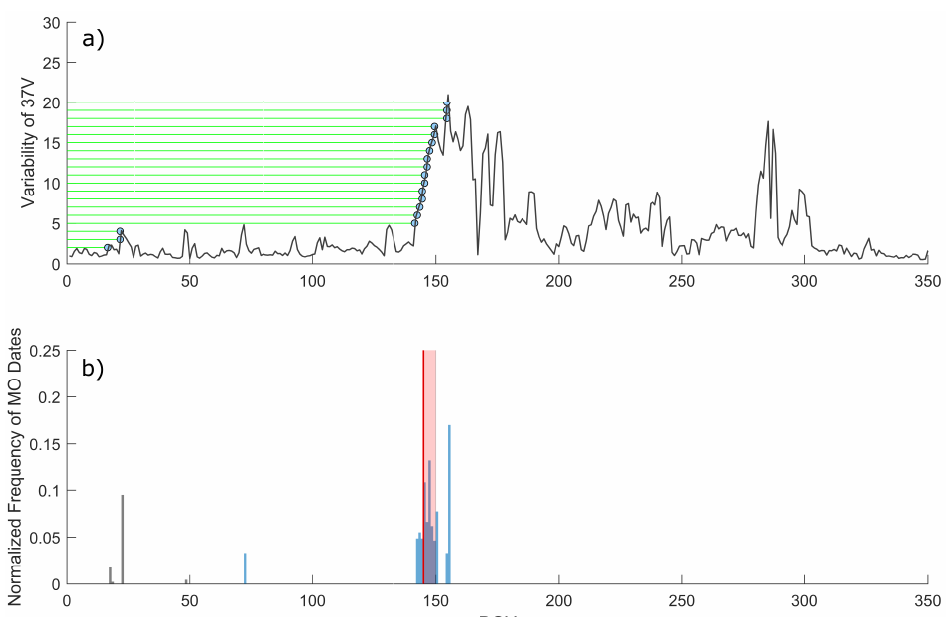
Figure 2. Data from pixel at [69.87 ◦ N, − 88.15 ◦ W], 2017. ( a ) Time series of the variability of TB37V over the entire year (black). A series of thresholds (green) and their corresponding MO dates (blue). ( b ) A histogram of MO dates corresponding to 500 potential threshold values. Blue bars represent values found within the melt range and grey bars represent values outside. The red line represents the 25th percentile of the accepted data which is then defined as the MO date and the red region represents the interquartile range